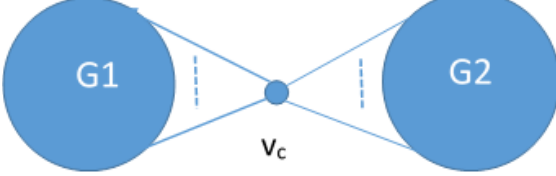
Figure 1: A realization G of d with a cut vertex v